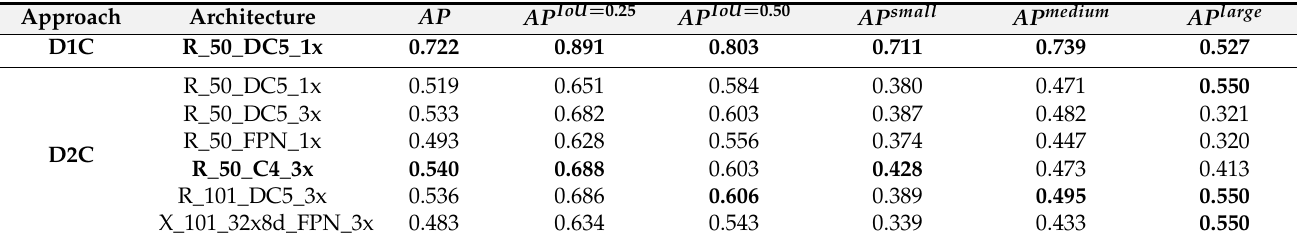
Table 3. Detection model performances based on AP . Architecture refers to the Mask R-CNN configurations available in the Detectron2 COCO-InstanceSegmentation [25].